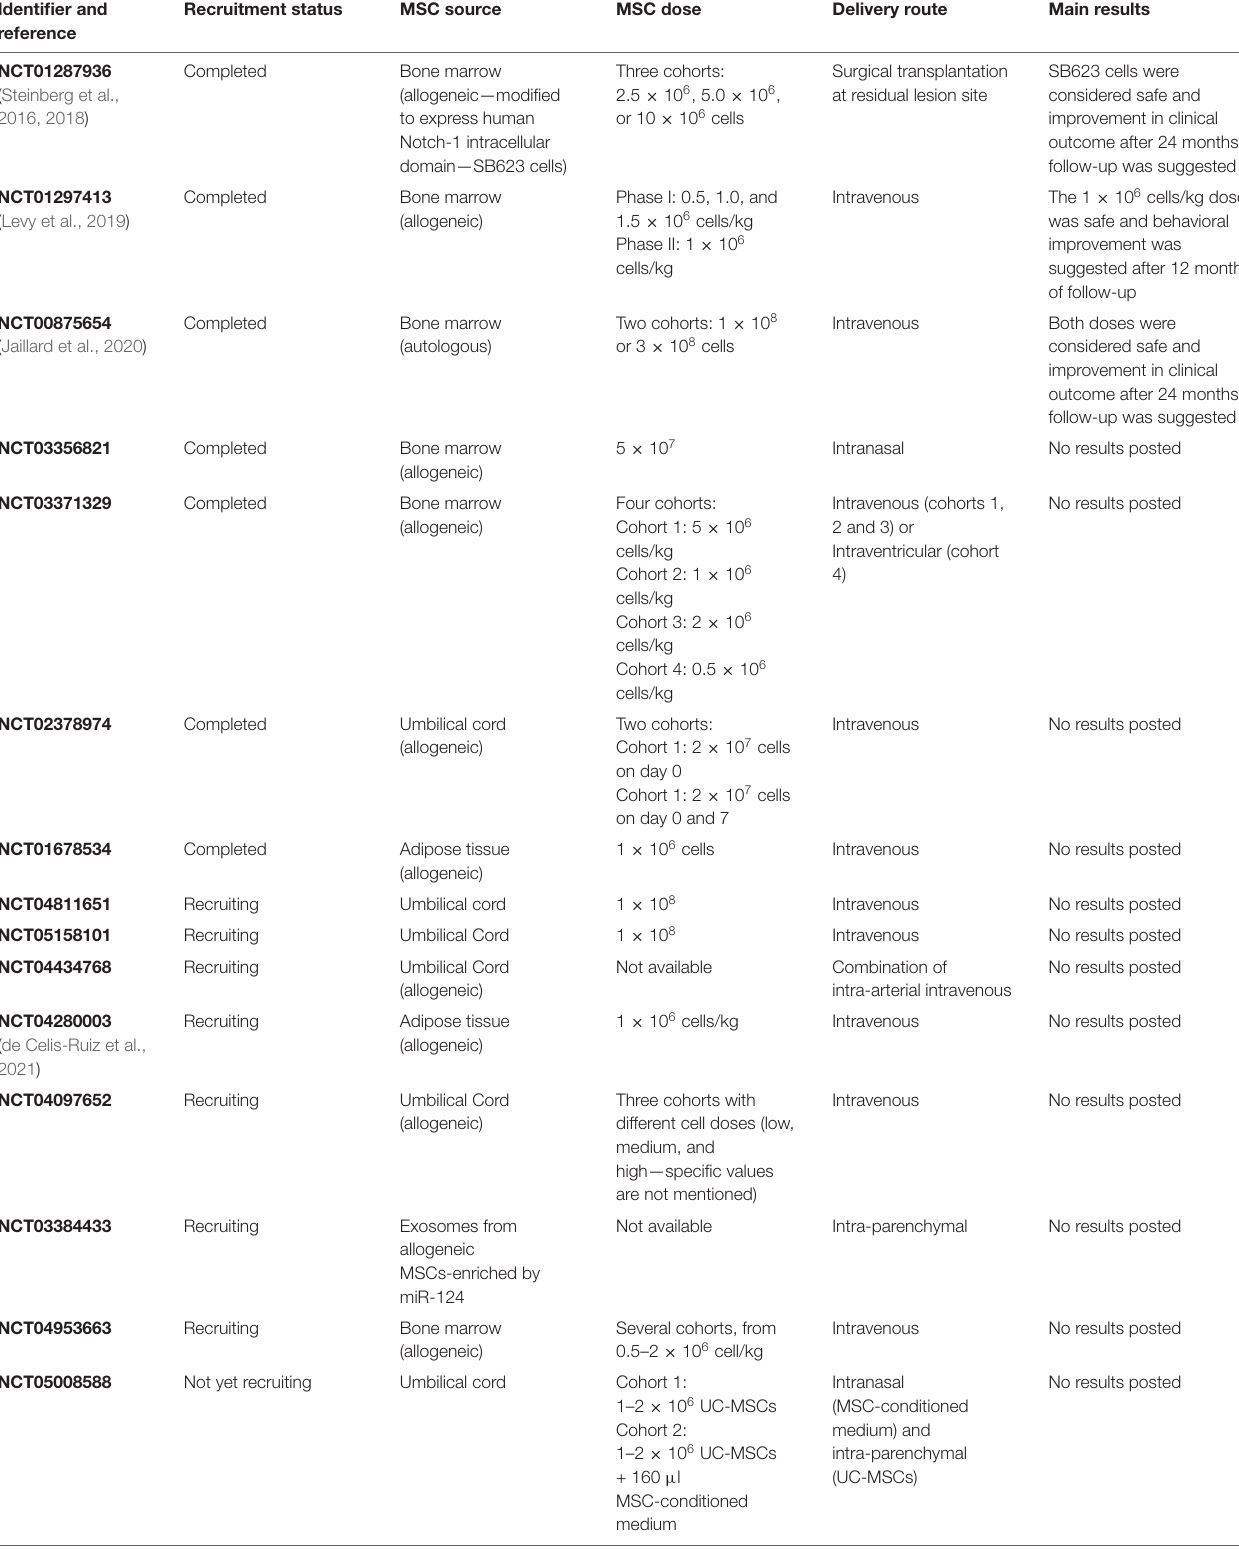
TABLE 3 | Clinical trials using mesenchymal stem/stromal cells in